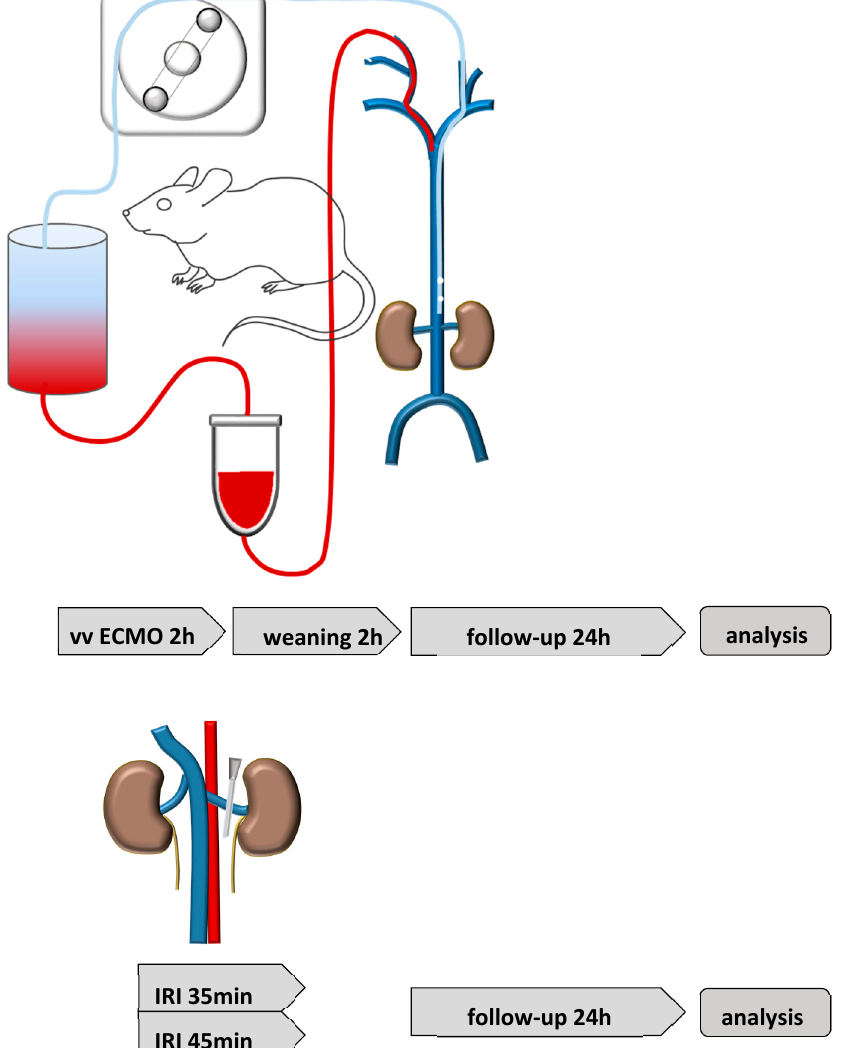
Figure 6. Experimental set-up. The vv ECMO ( upper row ) was performed by cannulation of the superior vena cava via the right jugular vein (red line) and the inferior vena cava via the left jugular veins (blue line). Mice were kept on ECMO support for 2 h. Weaning from ECMO was performed for additional 2 h. Kidney tissue analysis was performed either after the weaning period or 24 h after weaning from ECMO. Unilateral renal IRI ( lower row ) was performed for 35 min or 45 min and analysis was performed 24 h after renal